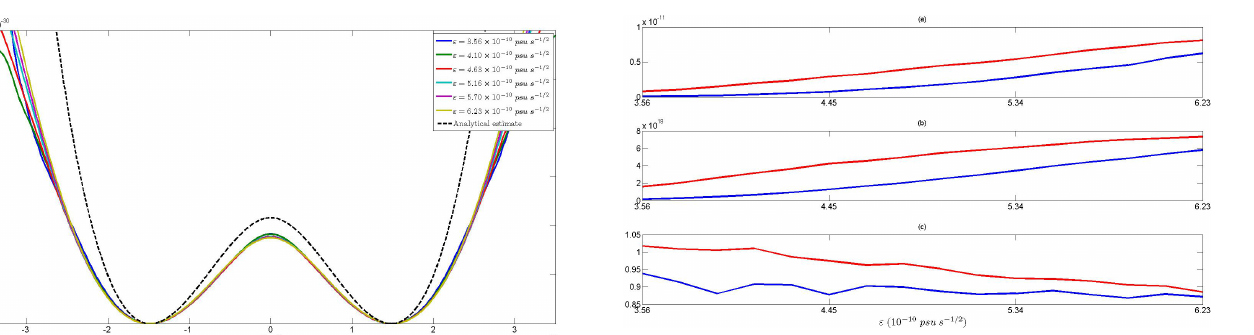
Fig. 4. One-dimensional efficient potential V eff (q) controlling the evolution of the THC strength in the 2 d.o.f. model with symmet- ric noise. The results of some numerical experiments are shown together with the analytical estimate.